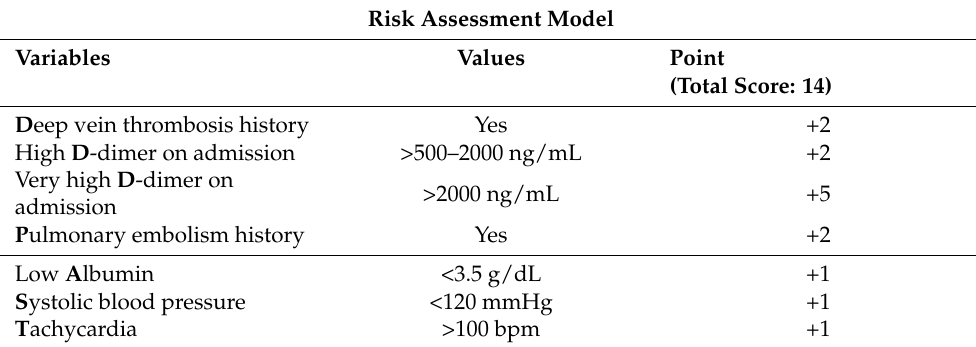
Figure 2. Forest plot of multivariable logistic regression showing seven variables with log-odds along with a 95% confidence interval from derivation cohort predictive of acute venous thromboembolism. Table 2. The 3D-PAST risk assessment model with assigned